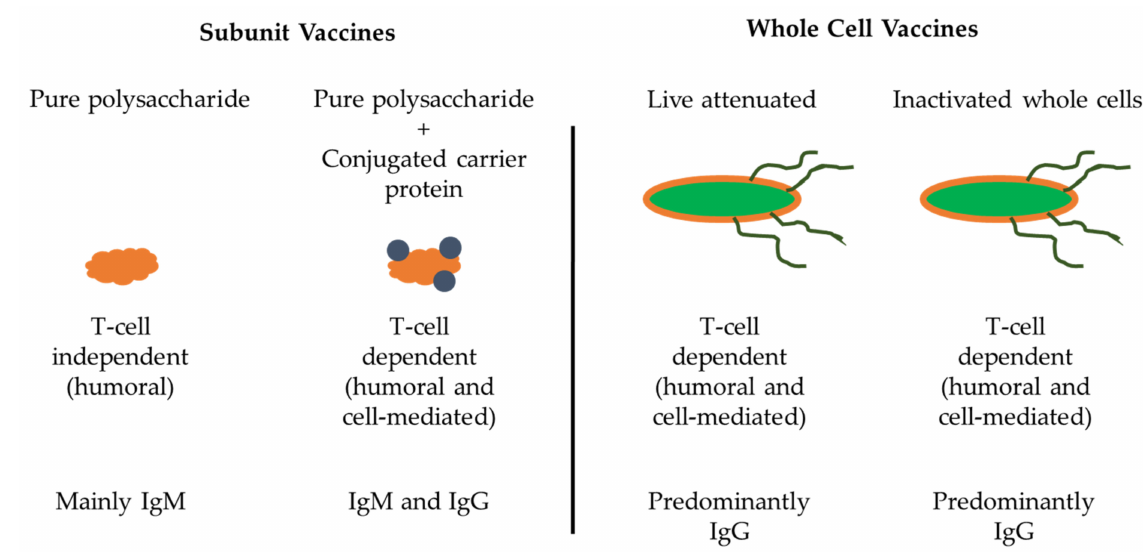
Figure 3. General concepts for development of vaccines. Pure polysaccharide vaccines are T-cell-independent activators of B-cells and their use usually results in an antibody only response (i.e., IgM). Polysaccharide–protein conjugate vaccines typically generate both humoral and cell-mediated immune responses. Both live-attenuated (i.e., mutagenesis) and inactivated whole-cell (i.e., heat or chemically inactivated) vaccines mount a mixed cell-mediated and humoral response dominated by IgG